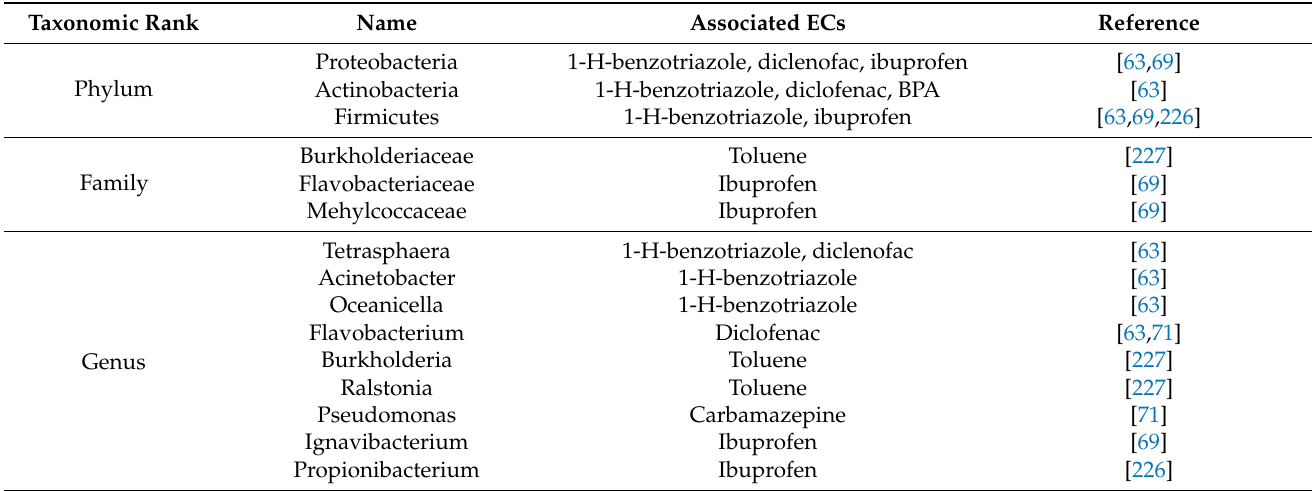
Table 6. Examples of microbial taxa associated with the degradation of emerging contaminants in